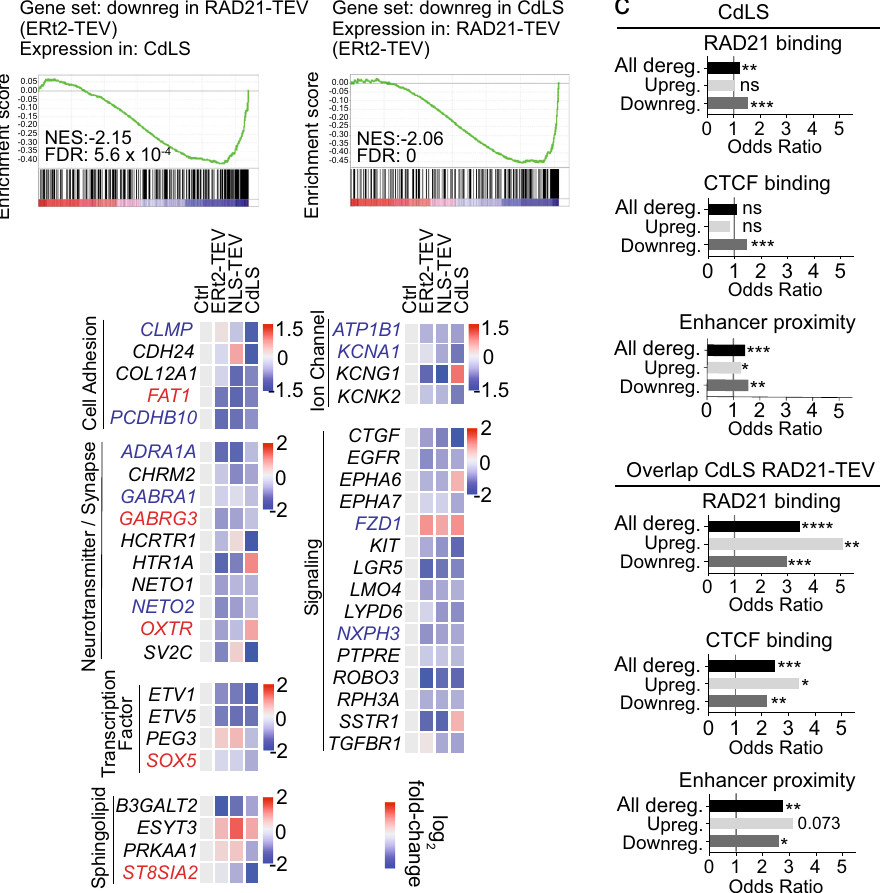
Fig. 3 Cohesin-dependent gene regulation in CdLS neurons. a GSEA of RAD21-TEV downregulated genes in CdLS NeuN-positive RNAseq (left). GSEA of CdLS NeuN-positive downregulated genes in RAD21-TEV (right). NES normalized enrichment score, FDR false discovery rate. b Heatmap of log 2 fold- change for selected genes from CdLS NeuN-positive and RAD21-TEV samples separated into broad functional categories. Genes shown were signi fi cantly deregulated in CdLS and their mouse orthologs deregulated in at least one RAD21-TEV (ERt2-TEV or NLS-TEV) system. Genes highlighted in red were identi fi ed in the SFARI database, those in blue were deregulated in ASD, genes highlighted in orange ful fi l both criteria. c Comparison of RAD21 (cohesin) binding (top), CTCF binding (center) and enhancer proximity (bottom, see methods) of genes deregulated (adj P < 0.05) in NeuN-positive CdLS (left) compared to genes deregulated in both NeuN-positive CdLS and RAD21-TEV (right). Up- and downregulation indicates the direction of deregulation in CdLS NeuN-positive RNAseq. One sided Fisher ’ s exact test was applied for the odds ratio and P value. * P < 0.05, ** P < 0.01, *** P < 0.001, **** P < (40 of 51 for ERt2-TEV, 42 of 57 for NLS-TEV, Fig. 3b). Of the 81 pared cohesin-dependent genes identi fi ed in Rad21 Tev/Te v neu- genes that overlapped between CdLS and one or both of the rons with gene expression in CdLS patient neurons. Gene set RAD21-TEV depletion systems, 23 were ASD risk genes 41 or deregulated in ASD (Ref. 38 ). These shared ASD genes mediate enrichment analysis (GSEA) showed remarkable concordance between genes that were downregulated in CdLS and in mouse important neuronal functions in cell adhesion ( CLMP, FAT1, neurons acutely depleted of RAD21-TEV. Genes that were PCDHB10 ) signalling ( PRKD1, NXPH3, FZD1, PHLDA1, downregulated in Rad21 Tev/Te v neurons 24 h after ERt2-TEV- PMEPA1, CAMK2G ), ion channels ( ATP1B1, KCNA1 ), synaptic induced cohesin depletion showed, as a set, signi fi cant down- transmission ( LGI2, GABRA1, GABRG3, NETO2 ), transcription regulation also in CdLS patient neurons (NES = − 2.15, ( SOX5, CECR2, CELF6 ) and sphingolipid metabolism ( ST8SIA2 ) FDR = 5.6 × 10 − 4 , Fig. 3a). The reciprocal test con fi rmed this (Fig. 3b, Supplementary Table 1). concordance and showed that genes downregulated in CdLS were overall downregulated in Rad21 Tev/Te v neurons (NES = − 2.06, FDR = 0.00, Fig. 3a). For upregulated genes there was no such concordance (NES = 1.28, FDR = 0.13 and NES = + 1.04, FDR = 0.35, respectively). Accordingly, a signi fi cant number of genes were deregulated both in CdLS patient neurons and after acute cohesin depletion of mouse neurons (51 in CdLS and ERt2-TEV, 57 in CdLS and NLS- TEV, 81 shared overall, Odds ratio = 2.48, P = 4.87e-11, of which 55 were downregulated, Odds ratio = 3.14, P = 4.06e-11). The majority of shared genes were deregulated in the same direction